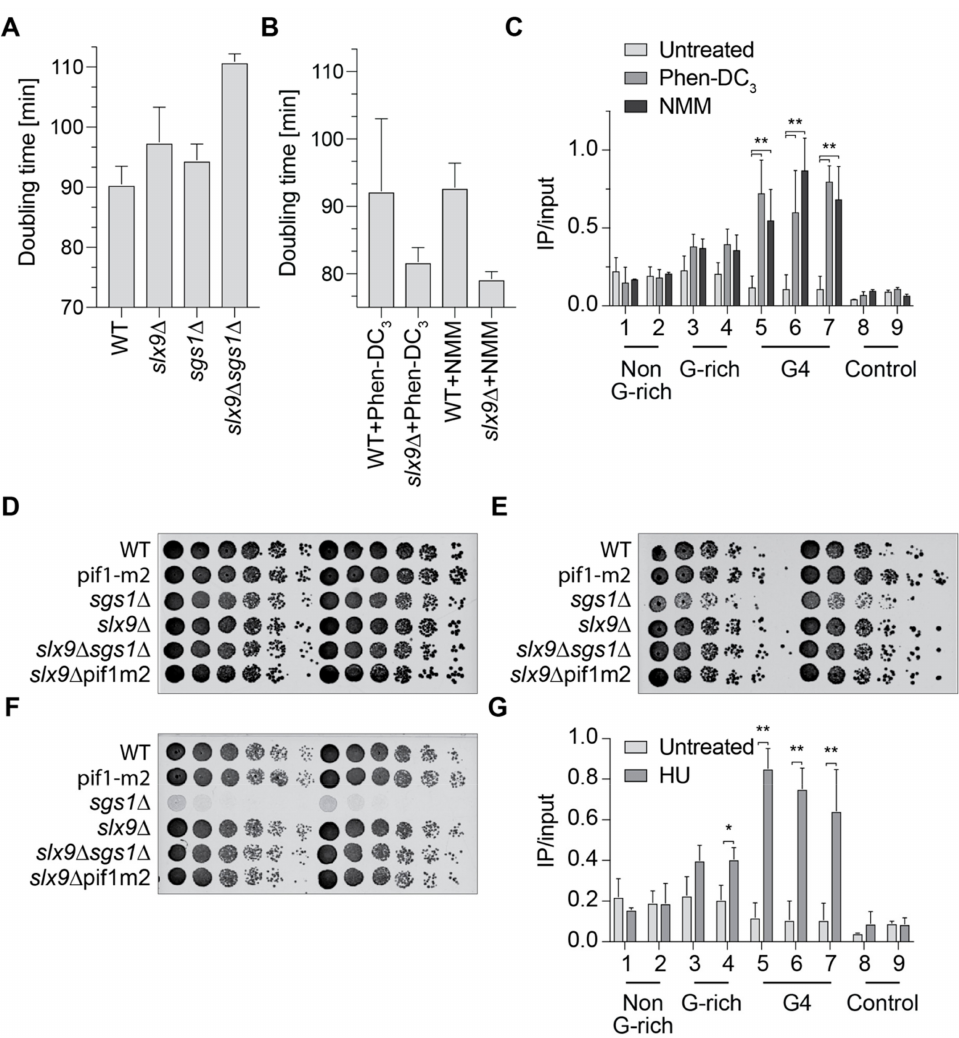
Figure 3. Slx9 supports the recognition of G4 structures in